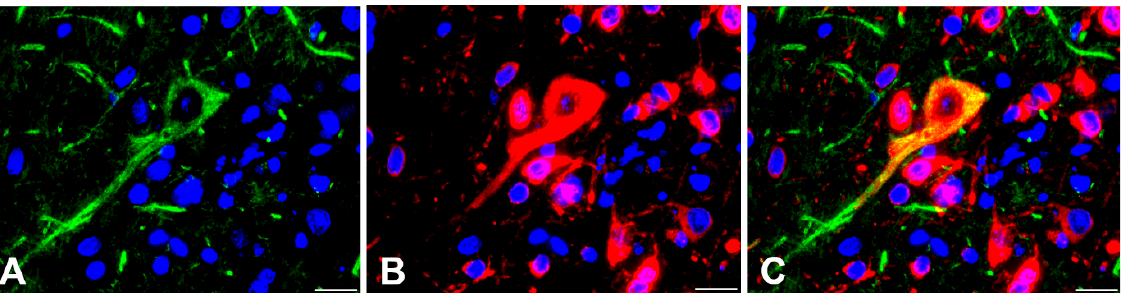
Figure 5. Double-labeling immunofluorescence for non-phosphorylated neurofilament (nNF) and Rift Valley fever virus (RVFV) nucleoprotein in the quadrigeminal lamina of a wild type of mouse at 9 days post infection with 10 4 plaque-forming units RVFV. ( A ): Illustration of nNF in the neuronal soma and processes (Cy2-conjugated, green). ( B ): Visualization of RVFV antigen (Cy3-conjugated, red). ( C ): Superimposed signals of nNF and RVFV demonstrate the presence of RVFV antigen in the soma and axon of a neuron. Nuclei are stained with bisbenzimidine (blue). Bars = 20 µm.